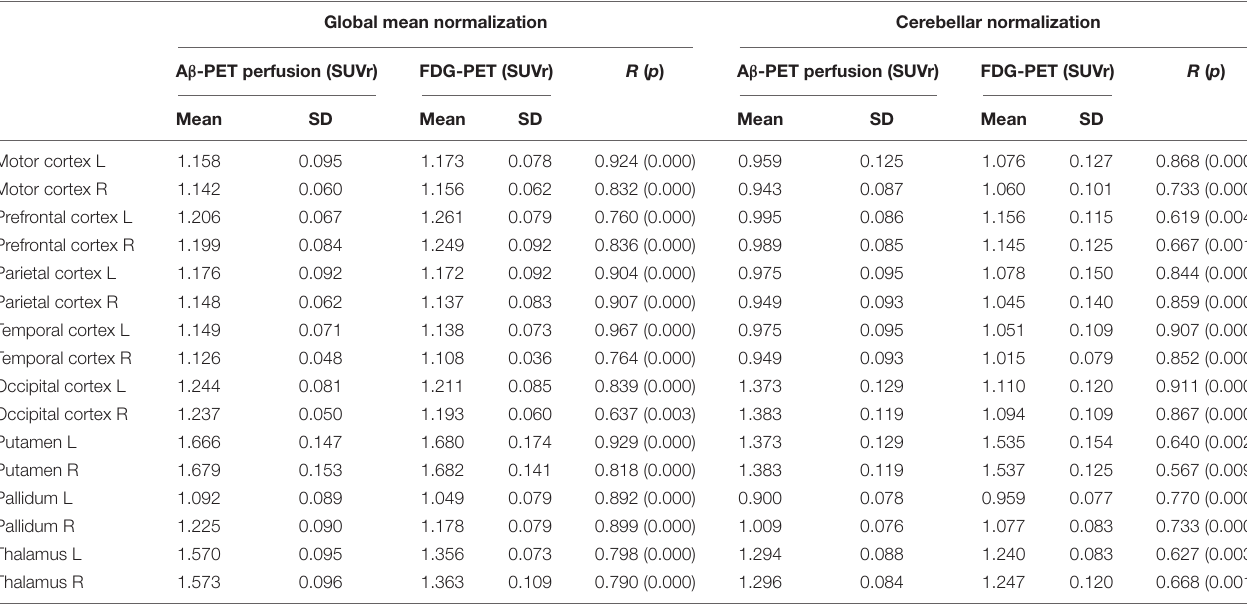
TABLE 2 | Semiquantitative results of early-phase A β -PET and